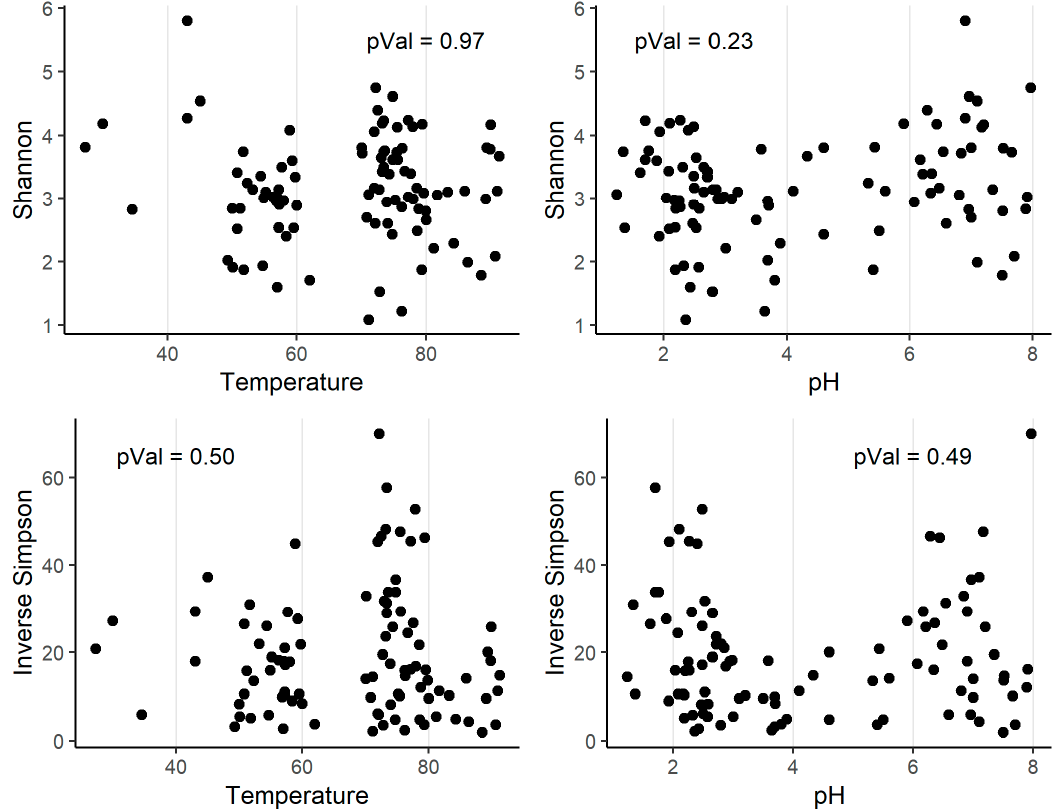
Figure 4. Alpha diversity indexes and their correlations with pH and temperature (°C). The p -value of the Spearman’s rank correlation coefficient (Rho) is shown.